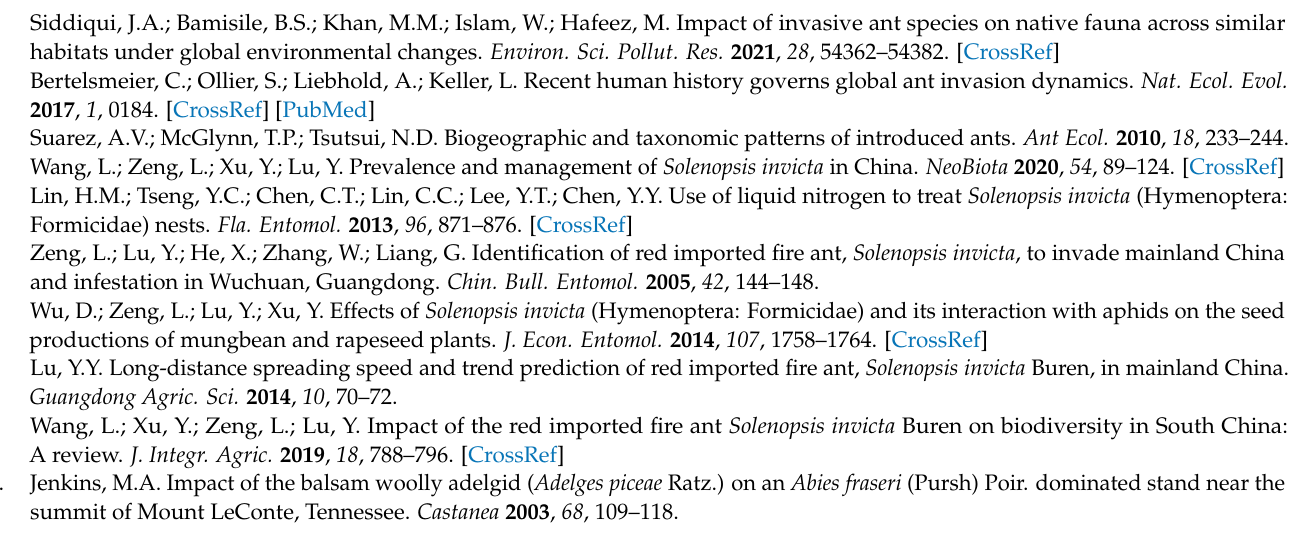
Supplementary Materials: Figure S1: Collection sites of Solenopsis invicta (Coloured areas with red spots), Table S1: List of forward and reverse primers used in qPCR, Table S2: List of genes of interest with fold change, Table S3: List of DEGs involving insecticide-related metabolic pathways, Table S4: List of genes and gene expression in control and after LC 30 application specifically related to insecticide detoxification, Table S5: List of the raw and clean reads of all samples, Table S6: List of base pairs before filters and after filter along with raw and clear data, Table S7: List of significant DEGs annotations related to insecticide detoxification, Table S8: List of KEGG pathways along with upregulated and downregulated genes, Table S9: List of gene ontology (GO) terms along with up and downregulated